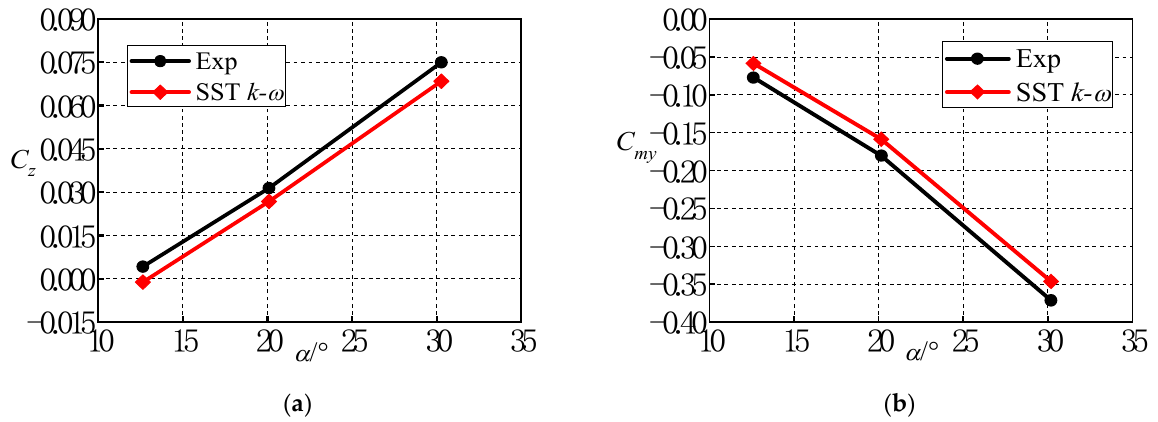
Figure 6. Variation of the time-average aerodynamic coefficients with the angles of attack: ( a ) Lateral force coefficient; ( b ) Yawing moment coefficient.